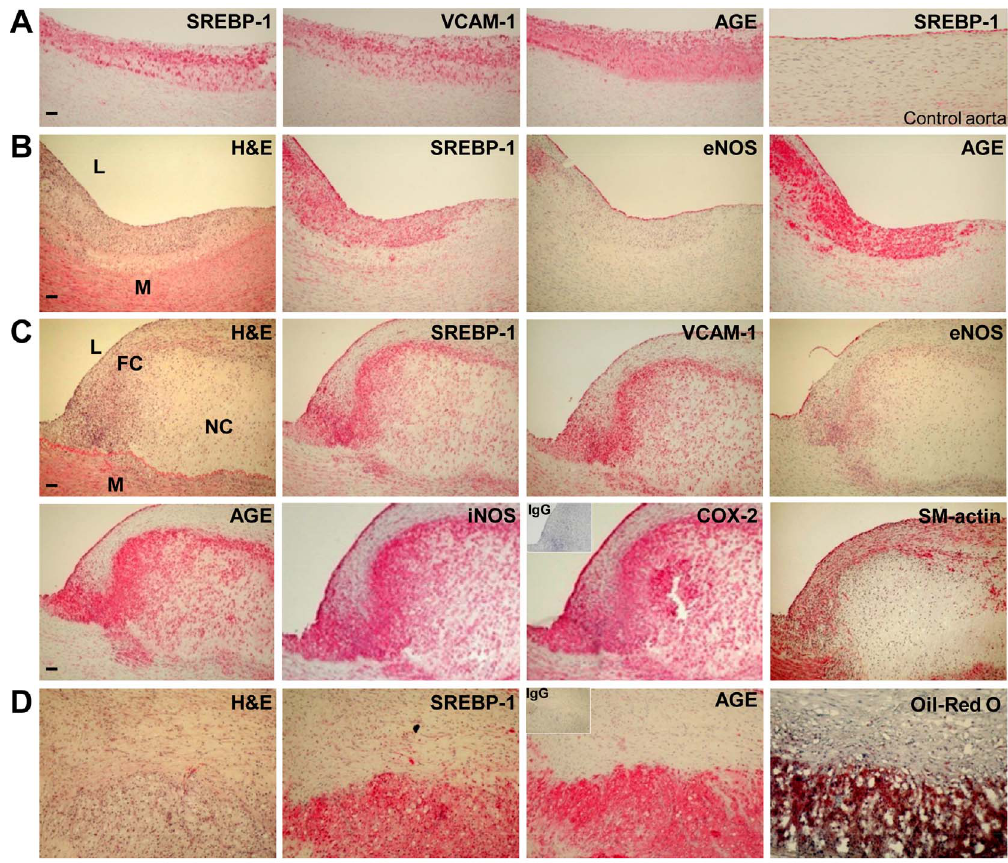
Figure 7. Immunostaining for SREBP-1 and vascular inflammatory mediators in a mixture of early/intermediate stage lesions and advanced plaques of diabetic, atherosclerotic pigs. A representative immunohistochemical staining of adjacent aortic sections of normal pigs and diabetic, atherosclerotic pigs is shown (scale bars: 100 m m). Positive immunostaining appeared red color. Immunostaining for SREBP-1 (a lipogenic marker) was located primarily in endothelial cells and in macrophage infiltration areas of fatty streaks ( A and B ), the inflamed fibrous cap with the necrotic lipid core (L=lumen, M=media, FC=fibrous cap, and NC=necrotic lipid core) ( C ), and lipid-laden foam cells and large numbers of cholesterol crystals under subendothelial lesion areas that were strongly stained by Oil Red O ( D ). Immunostaining for eNOS (an endothelial cell marker) showed impaired endothelium integrity in atherosclerotic lesions ( C ). Immunostaining for a -smooth muscle actin ( a -SM-actin) displayed intense staining in the fibrous cap, indicating the migration and proliferation of SMCs into the intimal lesions ( C ). Immunostaining for VCAM-1, iNOS, and COX-2 (vascular inflammatory markers) displayed a pattern similar to SREBP-1 distribution in atherosclerotic lesions ( C ). Immunostaining for AGE (advanced glycation end products, a glucotoxic marker) showed a pattern similar to that of SREBP-1, except the staining of AGE was much intense in endothelial cells of the fibrous cap and in the necrotic plaque of advanced lesions ( C ). Positive staining for SREBP-1, VCAM-1, iNOS, COX-2, or AGE was also localized in most of endothelial cells and lipid-laden macrophages and in some of a -SM-actin-expressing SMCs in advanced plaques ( C ). In contrast, positive staining for SREBP-1 was only detected in endothelial cells of normal pigs ( A ). The minimal staining for VCAM-1, iNOS, COX-2, or AGE was present in normal pigs (data not shown). The inset images in the top left demonstrate the negative control staining by the incubation with non-immuno IgG substituted for the primary antibody ( C–D ).